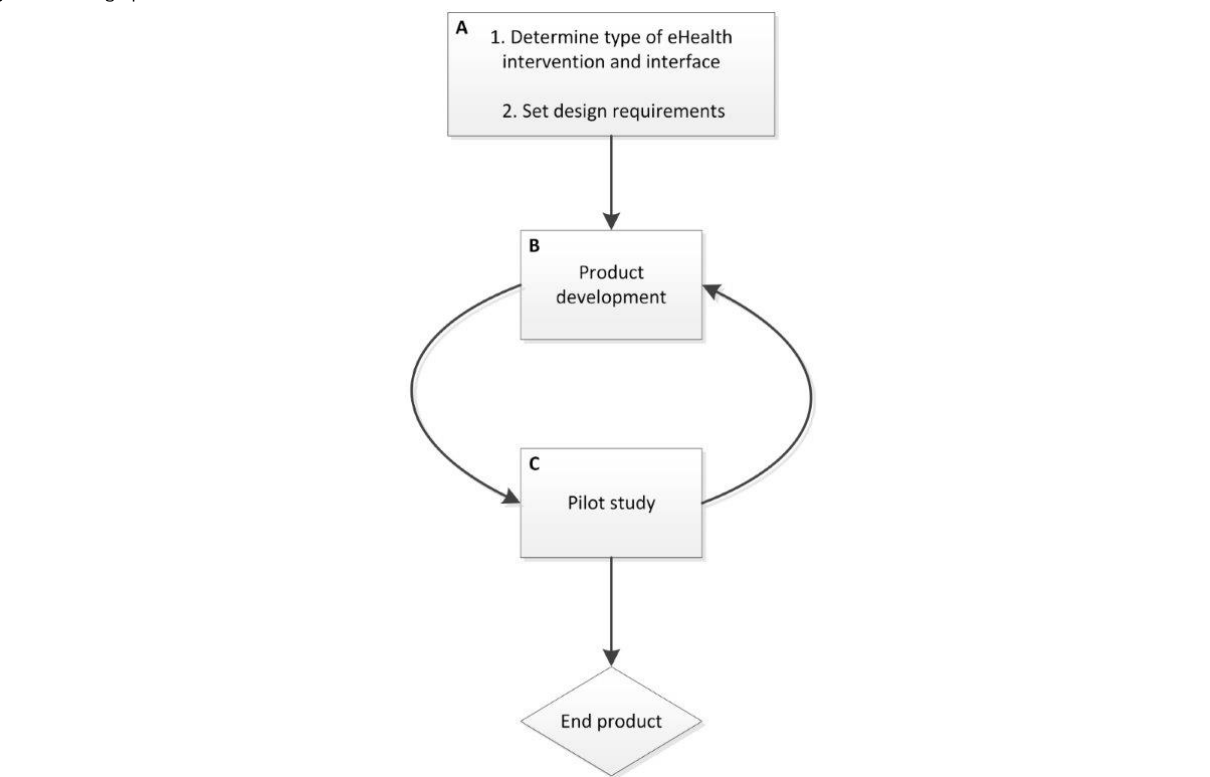
Figure 1. Design process.